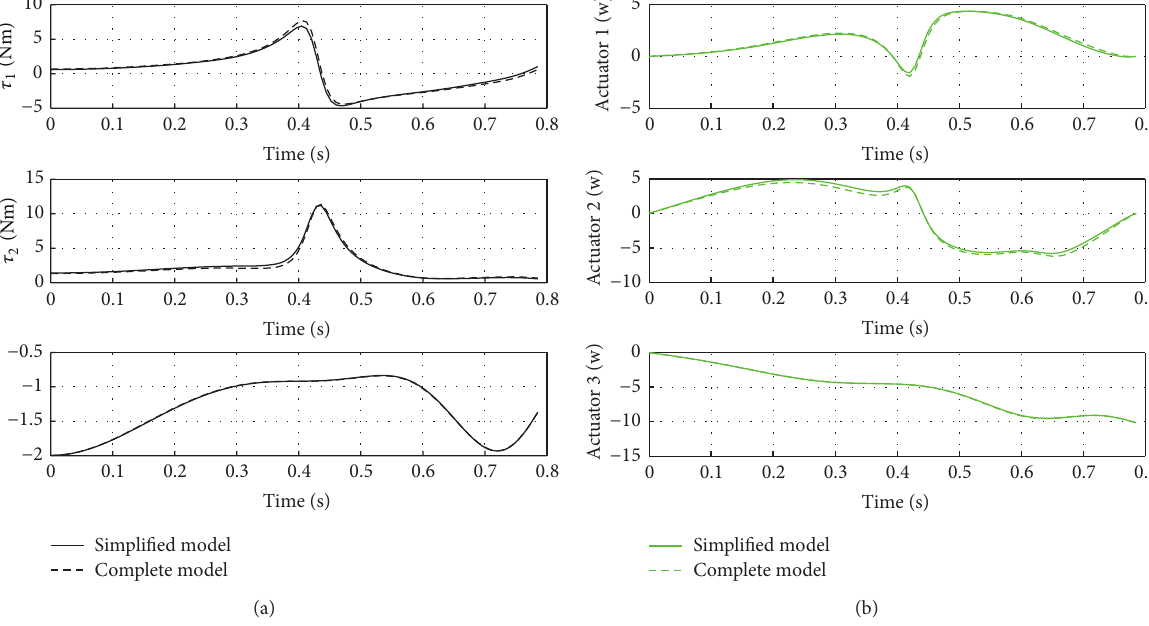
the smallest torque requirement on the third actuator but its output power is the highest among the three